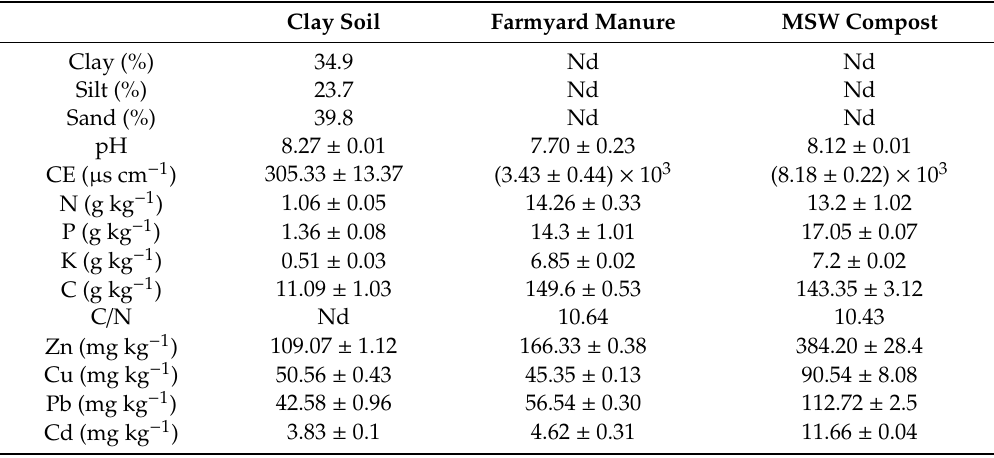
Table 1. The characteristics of clay soil, farmyard manure (M), and municipal solid waste compost (MSWC). Data are means of three repeats ± SE. Nd = not